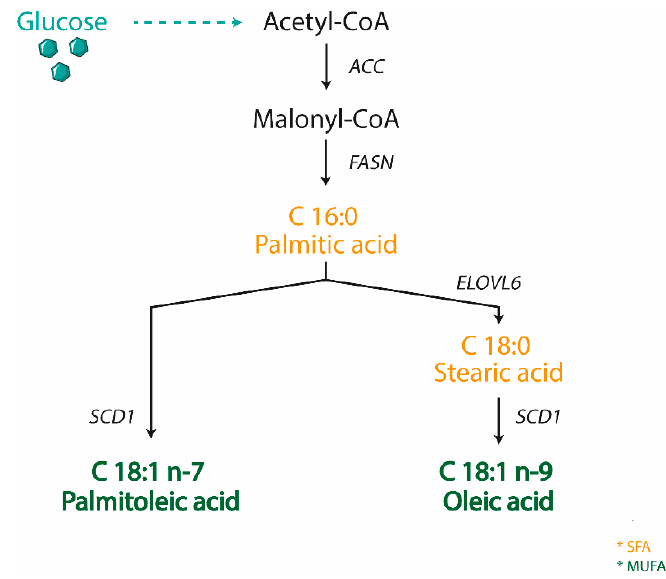
Figure 1. Scheme representing the biosynthesis of MUFA in animals. Stearoyl CoA Desaturase 1 (SCD1) catalyzes the rate-limiting step for the conversion of saturated fatty acid (SFA) into monounsaturated ones (MUFA). (ACC—acetyl CoA carboxylase; FASN—fatty acid synthase; ELOVL6—fatty acid elongases 6).